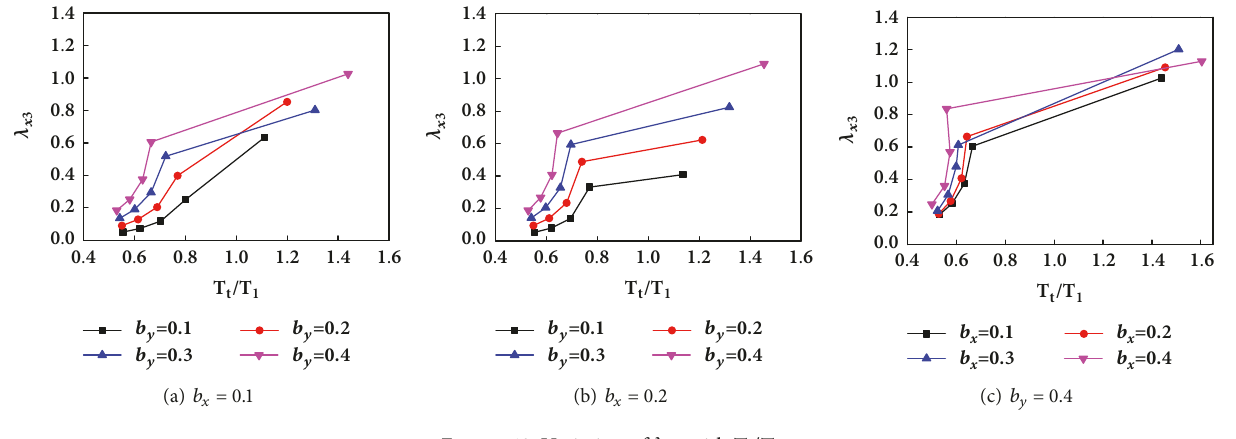
Figure 18: Variation of 𝜆 𝑥3 with 𝑇 t /𝑇 1 .